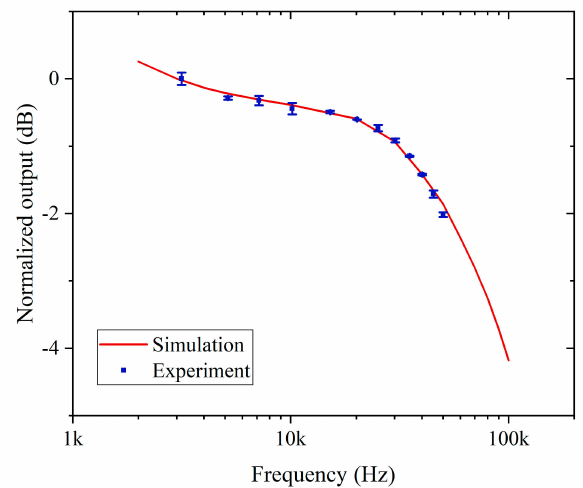
Figure 3. Normalized PT signal as a function of pump modulation frequency. The red line is calculated by COMSOL Multiphysics and the blue dots are the experimental data. Error bars show the standard deviation (s.d.) of measured